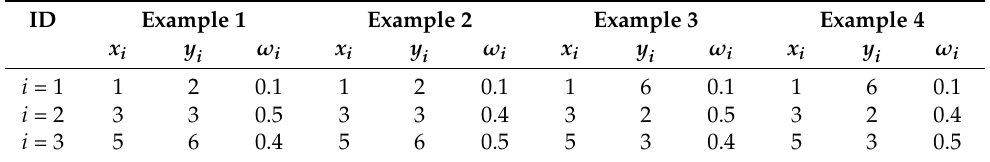
Table 2. Summary of data in four examples.